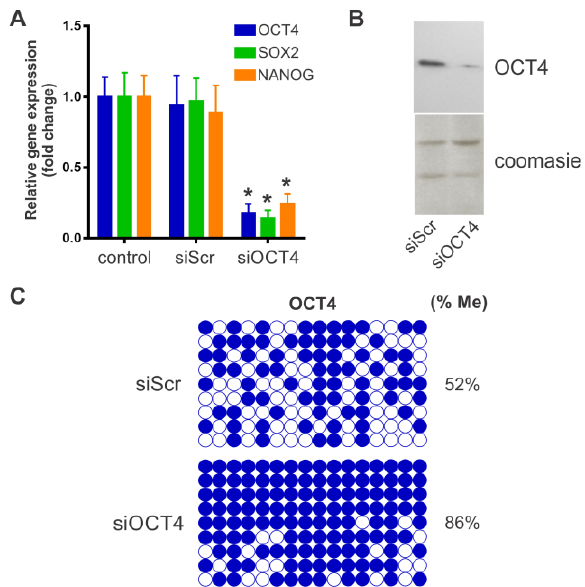
Figure 1. Phenotypic characterization of bone marrow-derived mesenchymal stromal/stem cells (BM-MSCs). Surface marker expression levels in BM-MSCs were analyzed by flow cytometry. MSCs highly express (>90%) the stromal determinants CD44, CD73, CD90, and CD105, and are negative (<2%) for the expression of hematopoietic markers (CD14, CD34, CD45). Representative dot-plots of three independent assays.